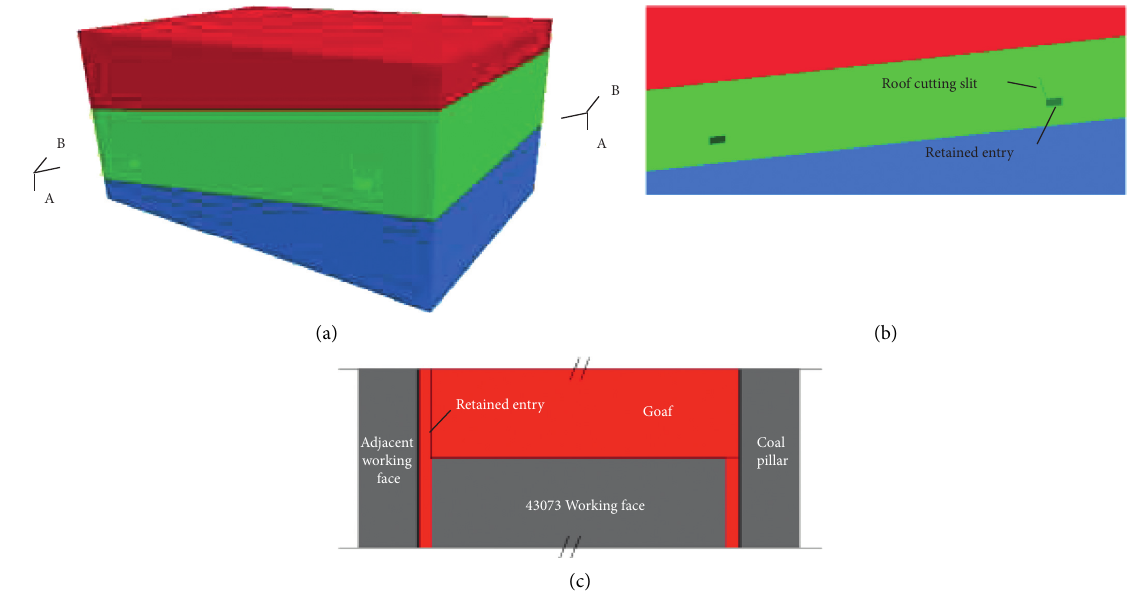
Figure 15: Numerical calculation model. (a) Three-dimensional model. (b) Section A-A. (c) Section B-B.